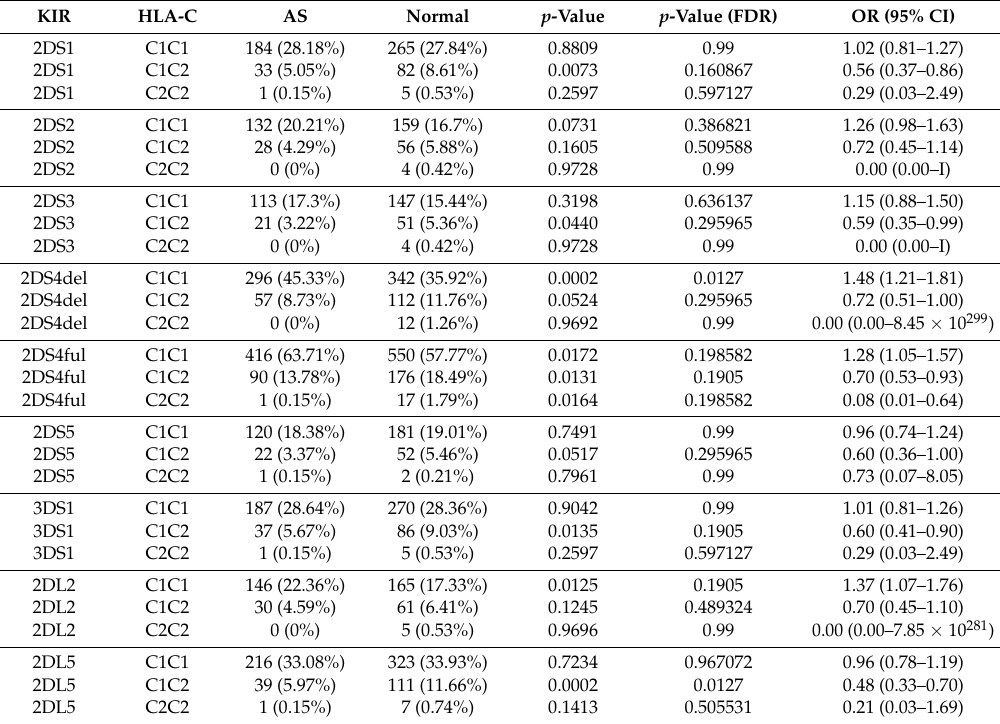
Table 5. Association of the KIR and HLA-C combinations with Taiwanese AS